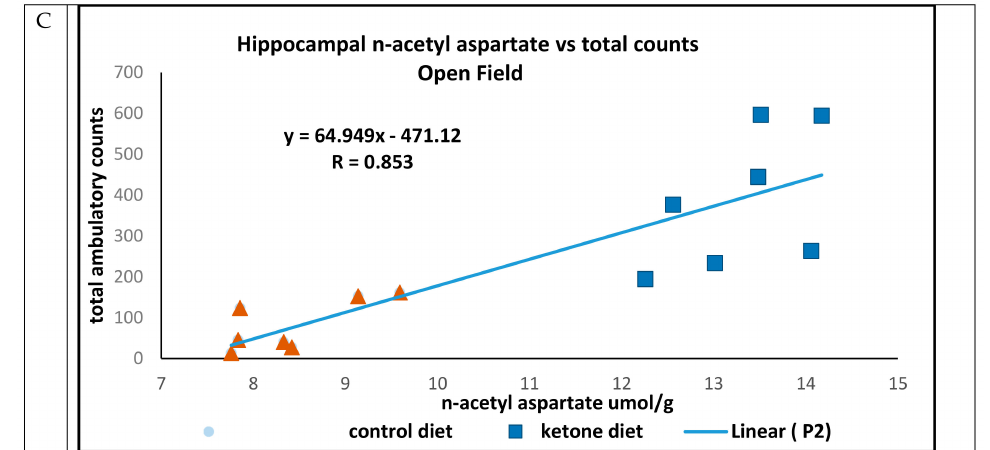
Figure 4. Open field assessments of 3xTgAd mice fed either a control diet (n = 7, triangle) or ketone ester diet (n = 7, square) for 8 months, measured at 15 months of age. ( A ) Linear correlations comparing concentrations of hippocampal n-acetyl aspartate (assayed at 16.5 months of age) versus total distance traveled, ( B ) hippocampal n-acetyl aspartate versus ambulatory time, and ( C ) hippocampal n-acetyl aspartate versus ambulatory